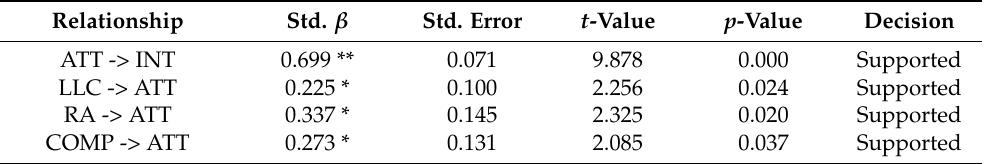
Table 16. Path coefficient and hypothesis